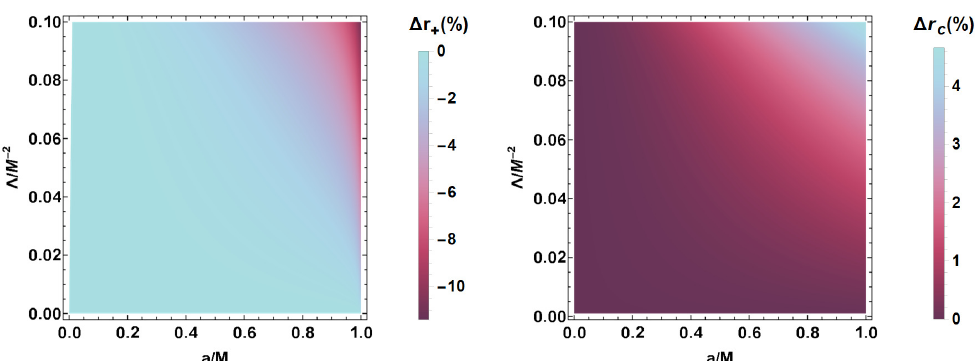
Figure 4. Density plot of the percentage deviation of the event horizon ( left ) and cosmological horizon ( right ) of the new Kerr–de Sitter black holes (3) from that of the Kerr–de Sitter black hole shown in parameter